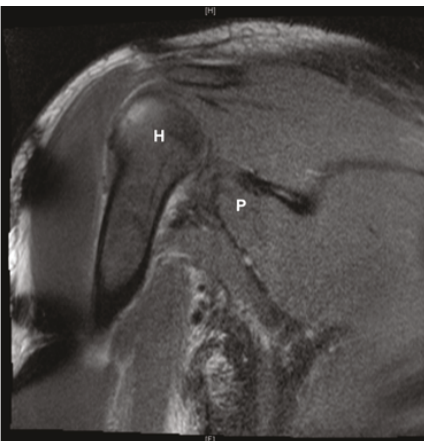
Figure 3: Coronal MRI image. H: humerus; P: retracted pectoralis major.